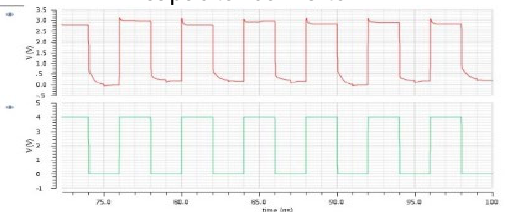
Figure 13. Schematic of proposed CMOS switched capacitor converter.